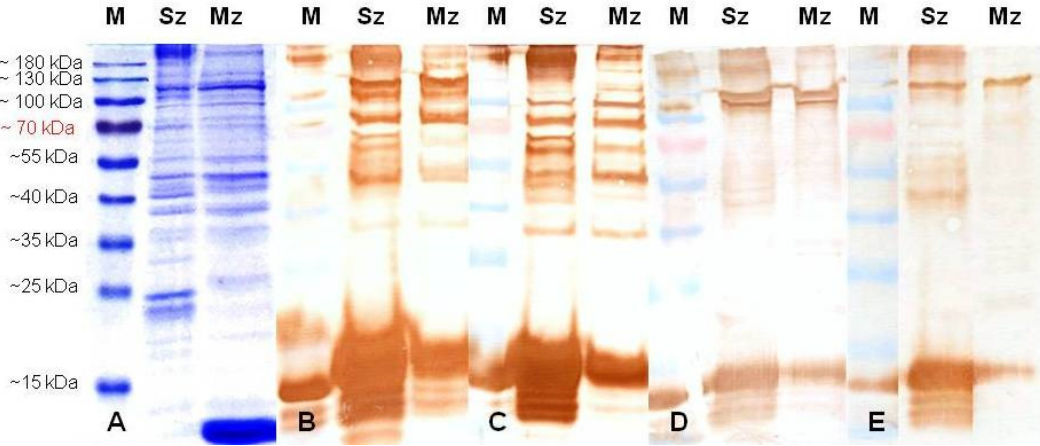
Figure 4. Proteins from the sporozoites (Sz) and merozoites (Mz) of the wild-type E. tenella strain resolved by 12% SDS-PAGE and stained with Coomassie Brilliant Blue ( A ) or probed in immunoblots with antisera (1:200) from two rabbits ( B , C ) and two SPF birds ( D , E ) at 28 days post-immunization with 5.3 × 10 6 whole sporozoites of E. tenella . M: molecular weight ladder in kDa.